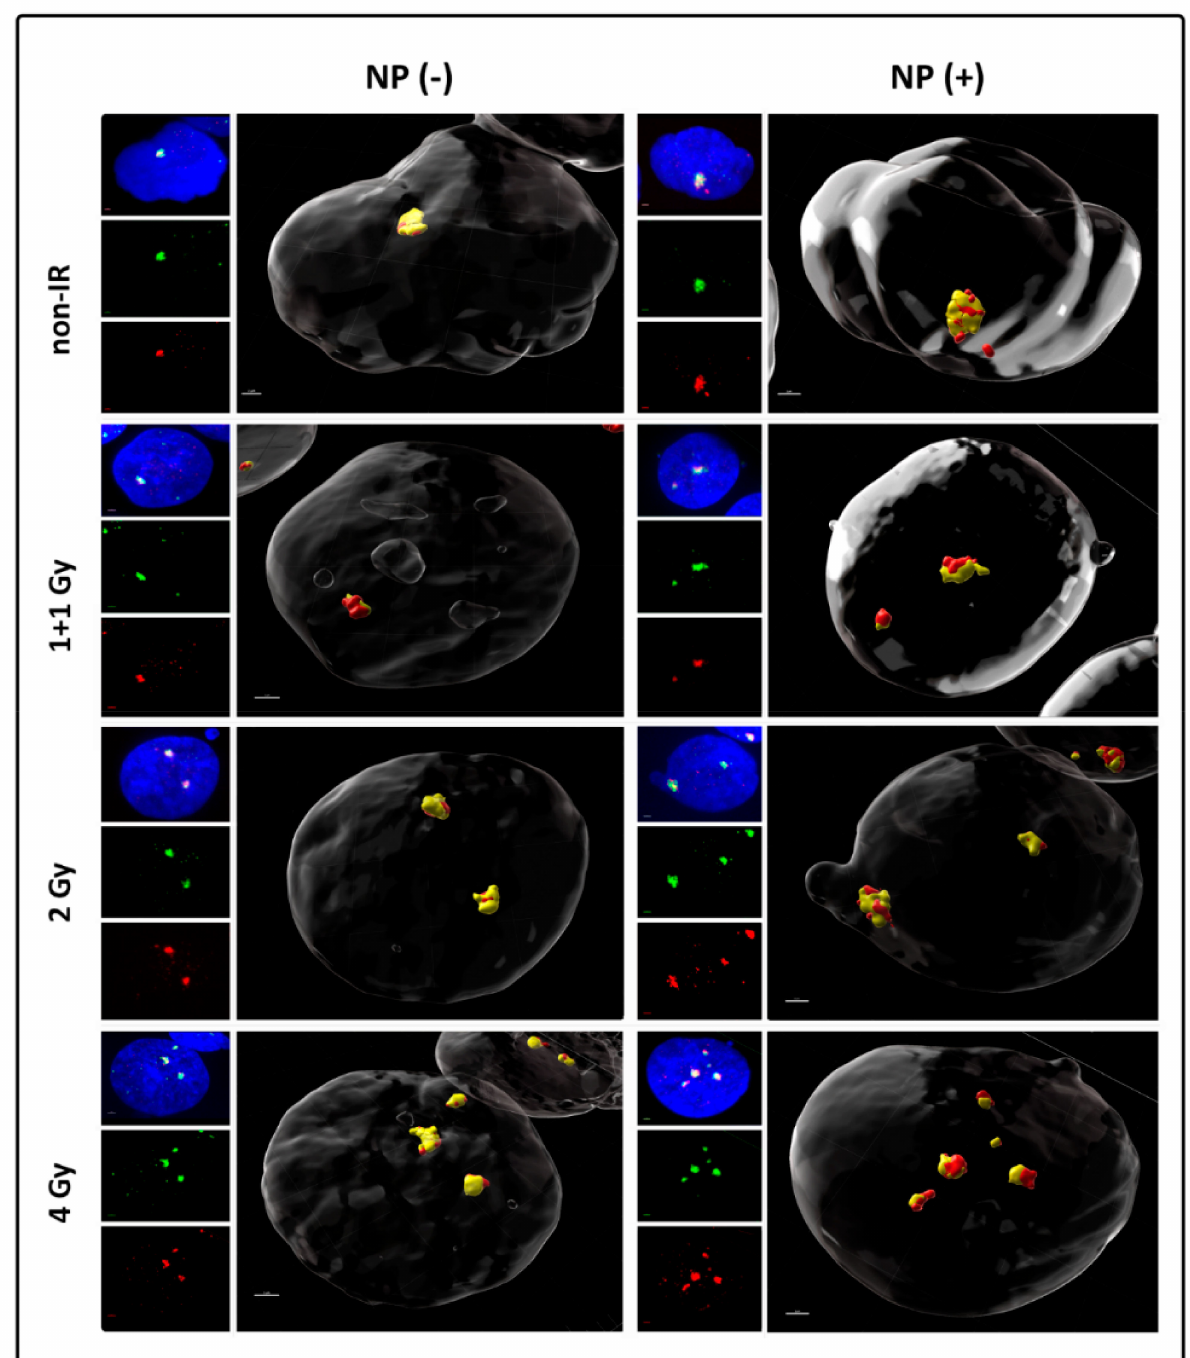
Figure 2. Persistence of non-reparable radiation-induced DSBs in SkBR3 cells as measured by γ H2AX ( green ) plus 53BP1 ( red ) repair foci persisting in cell nuclei 24 h PI. Repair focus numbers, their micro-morphology visualized in 3D space by Imaris software, and γ H2AX + 53BP1 colocalization are cross-compared for different γ -ray doses (1 + 1, 2 and 4 Gy) and cells irradiated in the absence ( left column ) or presence ( right column ) of GNPs (0.4 µ g/mL for 18 h at 37 ◦ C prior to irradiation). For better visualization, γ H2AX foci colocalizing with 53BP1 are displayed in yellow while all 53BP1 foci (including those colocalizing with γ H2AX) in